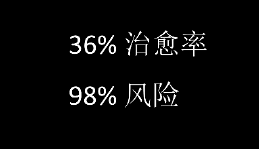
Figure 1. Example of experimental materials.